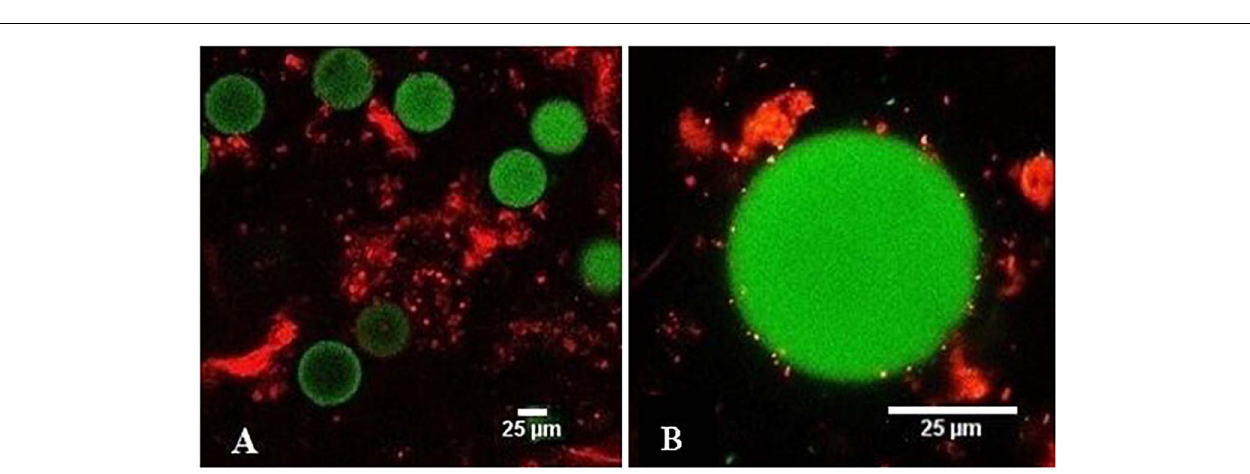
FIGURE 6 | Fluorescence images of PS microspheres in contact with the mucus observed by 20x objective (A) and 100 x objective (B) ; PS microspheres (green), mucus stained with propidium iodide